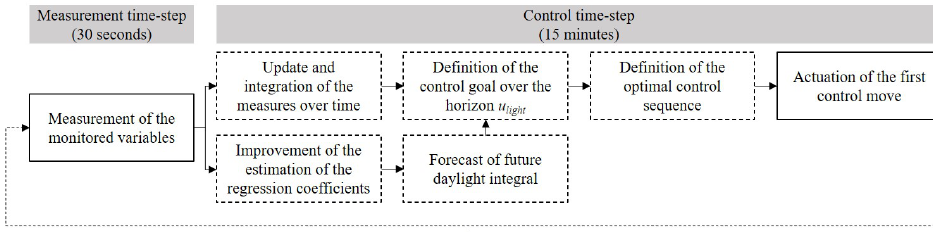
Figure 3. Computational steps of the proposed controller.